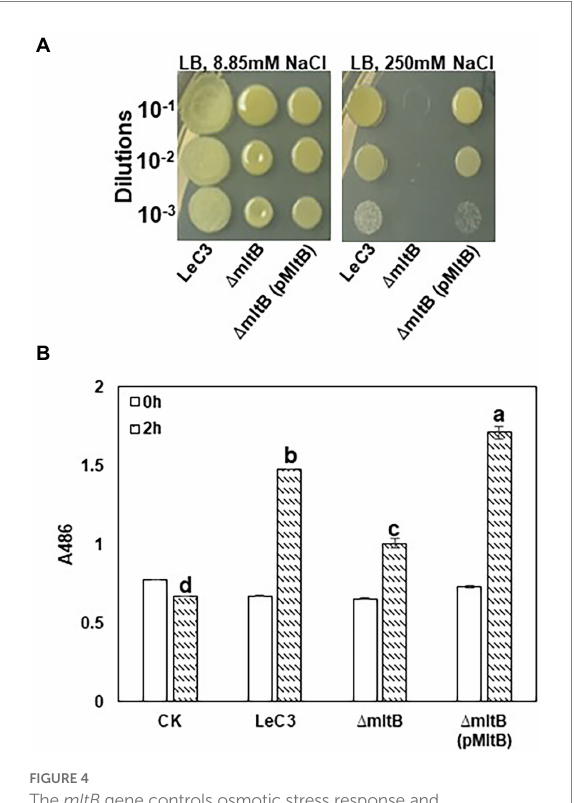
FIGURE 4 The mltB gene controls osmotic stress response and β -lactamase activity. (A) The mltB mutant showed decreased resistance to osmotic stress. Serial 10-fold dilutions were made from OD 600 = 0.1 in 0.5 × PBS. Each dilution was added to LB plates containing 8.85 mM NaCl (left panel) and 250 mM NaCl (right panel). Photographs were taken 3 days post-inoculation. (B) Quantitative measurements of β -lactamase activity in LeC3 and its derived strains. The β -lactamase activity was measured at 486 nm (A 486 ) using the chromogenic compound nitrocefin at 2 h post-inoculation. Error bars represented SD. Different letters indicated significant differences from one-way ANOVA followed by Fisher’s LSD test ( p < 0.05). LeC3, Lysobacter enzymogenes strain C3; mltB , the mltB mutant; and CK, 0.5 × phosphate- buffered in the 16S rRNA of L. enzymogenes . Sequence alignment (Supplementary Figure S1) revealed that point mutations between the 16S rRNAs of LeC3 and LaATCC29479 were in six different regions, and these included helix 10 ( E. coli